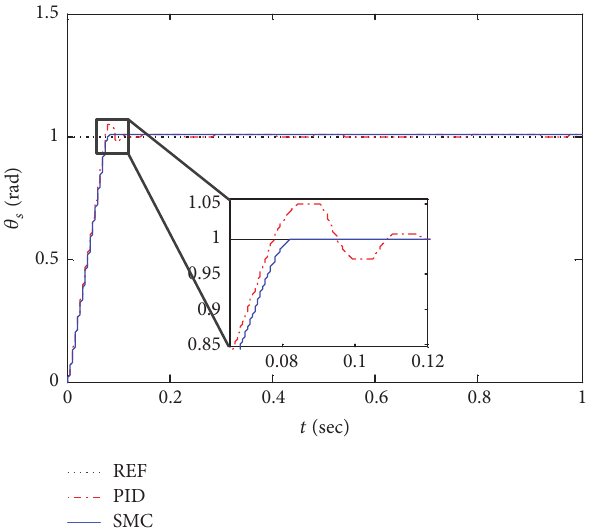
Figure 6: The tracking trajectory.